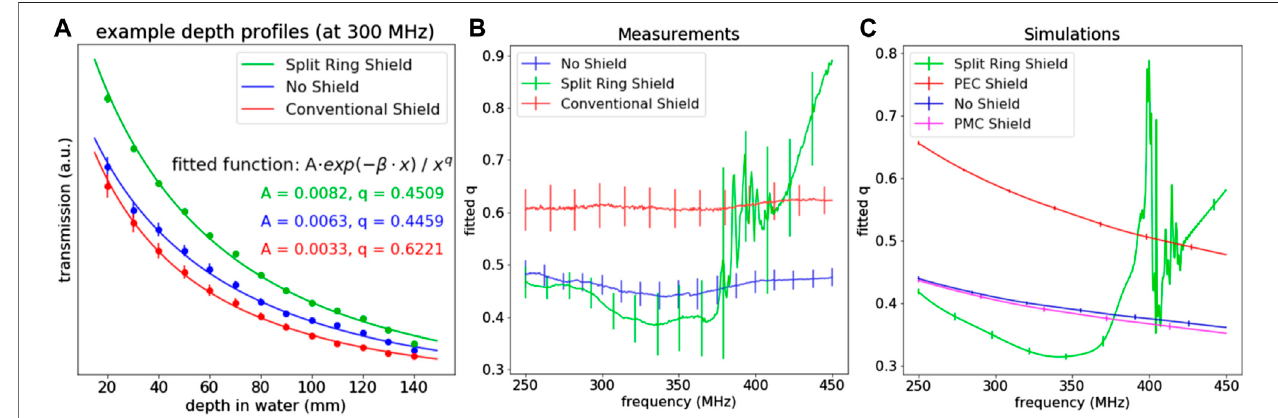
FIGURE 5 | (A) Three example depth pro fi les of measured transmission at 300 Mhz with SRS (green), without shield (blue) and with conventional copper shield (red). Parameters A and q resulting from fi tting Eq. 3 to these depth pro fi les are also shown. The numerical value of β is around 10.5 m − 1 at 300 MHz. (B) Averages of fi tted q from measured data as a function of frequency. (C) Fitted q from simulated data. Vertical bars signify 1 σ error margins.